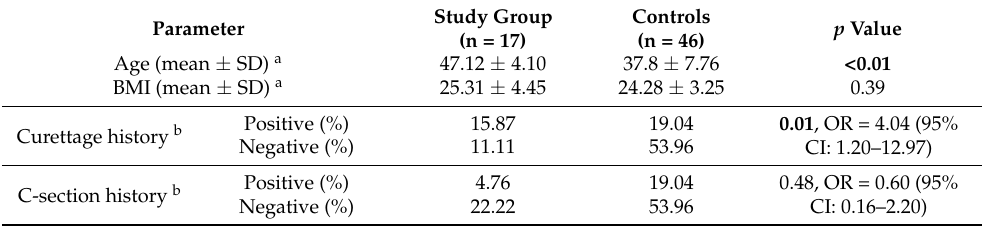
Table 1. Baseline characteristics comparison between the two study